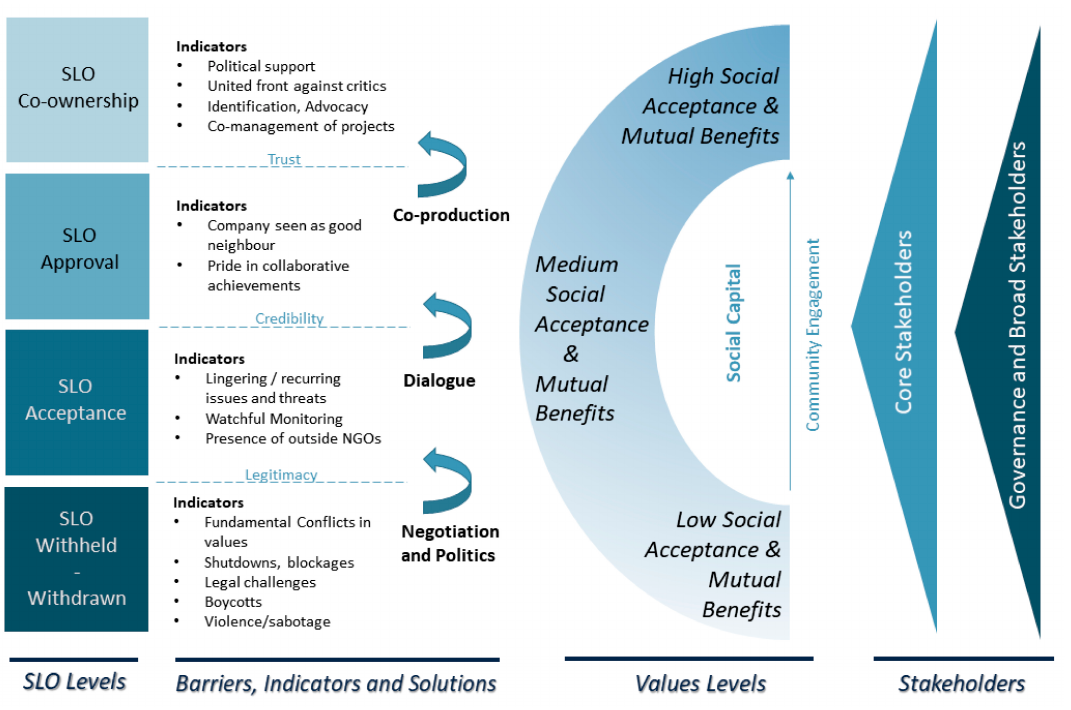
Figure 7. Conceptual Framework of SLO in Geothermal Energy.